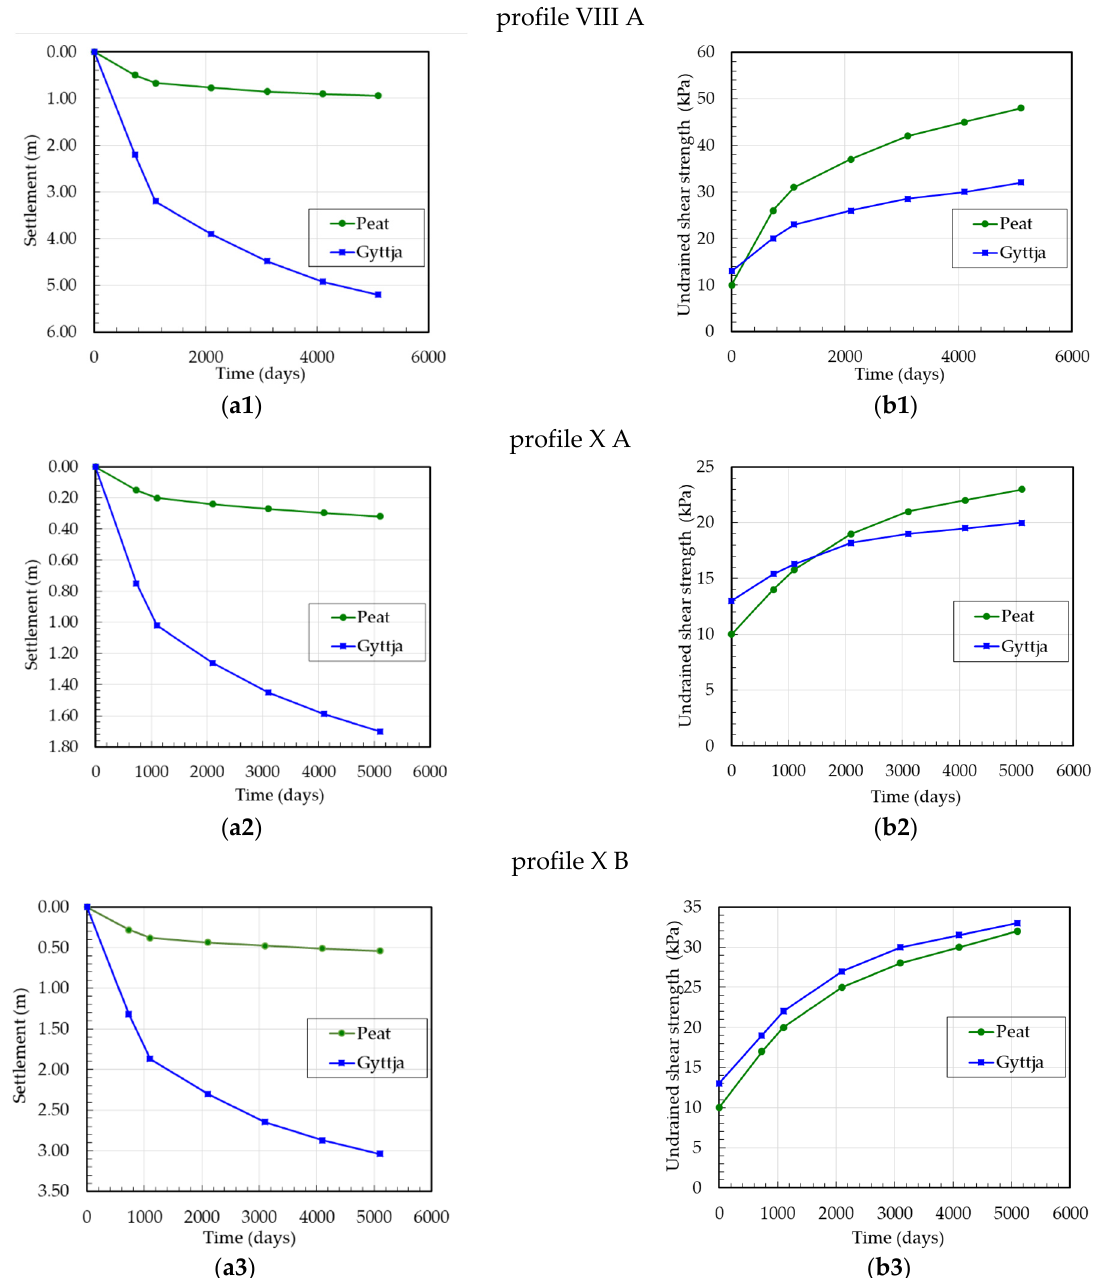
Figure 9. Test embankment at the Koszyce site: ( a1 – a3 ) settlement versus time, ( b1 – b3 ) undrained shear strength versus time.